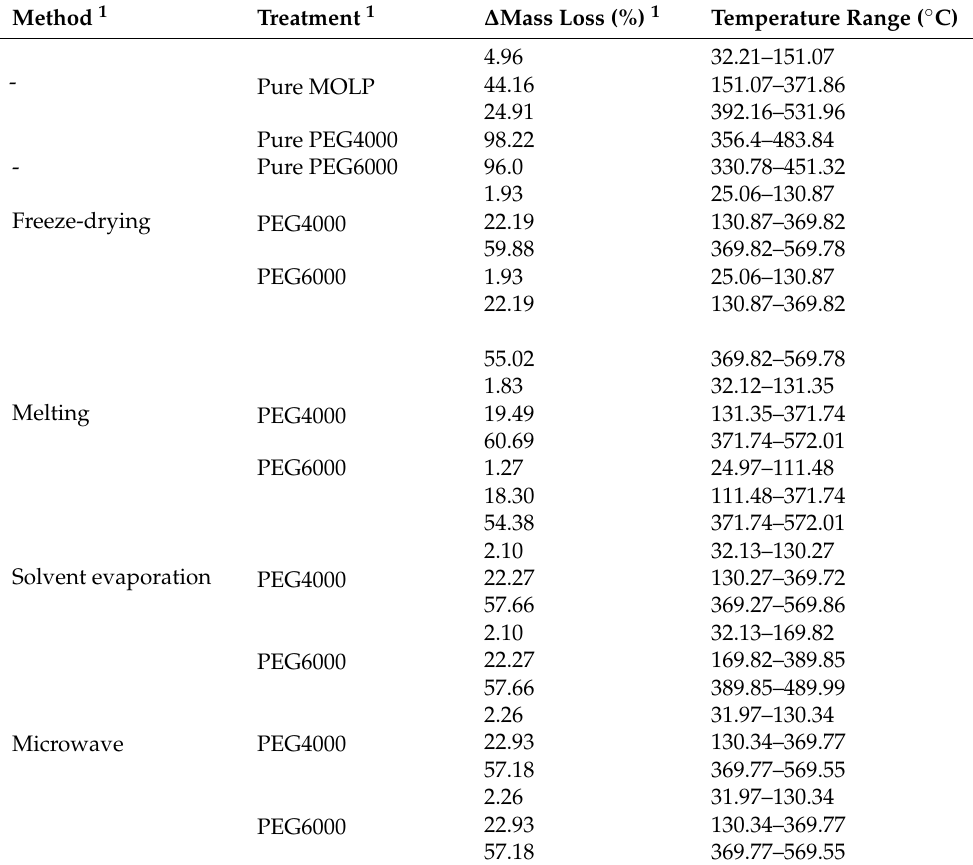
Table 2. Thermogravimetric data showing decomposition behavior of MOLP, PEG6000, and solid dispersions as a function of temperature at a heating rate of 10 ◦ C · min − 1